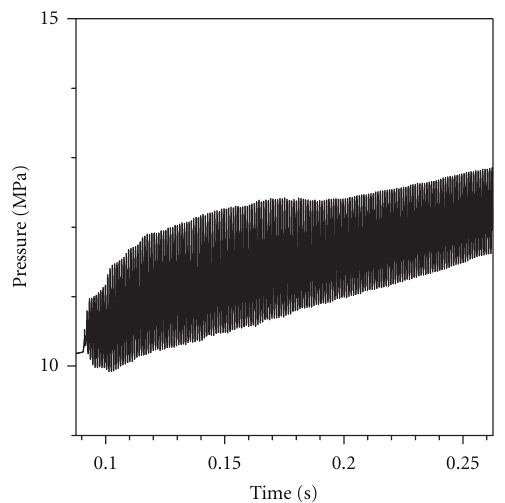
Figure 11: Predicted head-end pressure wave profile, reference motor ( K b = 20000 s − 1 , Δ H s = 150000 J/kg, Δ p d = 2atm, α p = 1 . 5%, d m 1 = 10 μ m, d m 2 = 5 μ m, d m 3 = 40 μ m, α p 1 = 0 . 5%, α p 2 = 0 . 5%, α p 3 = 0 . 5% ), three particle sets, acceleration active.